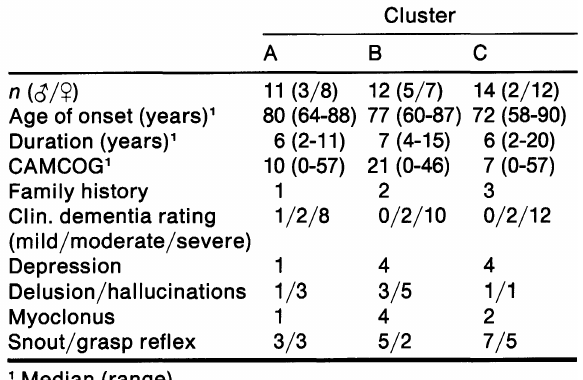
FIG. 2. Differences of neuron counts in the parietal lobe (F = 9.0, P < 0.001), parahippocampal gyrus (F = 17.0, P < 0.001), area CA1 of the hippocampus (F = 3.8, P < 0.05), frontal lobe (F = 8.3, P < 0.01) and locus coeruleus (F = 9.3, P < 0.001) between the patients in Cluster A (0), Cluster B (e) and Cluster C (~). 'Significant between-cluster diffferences (p < 0.05) after application of Scheffe's test for multiple comparisons.